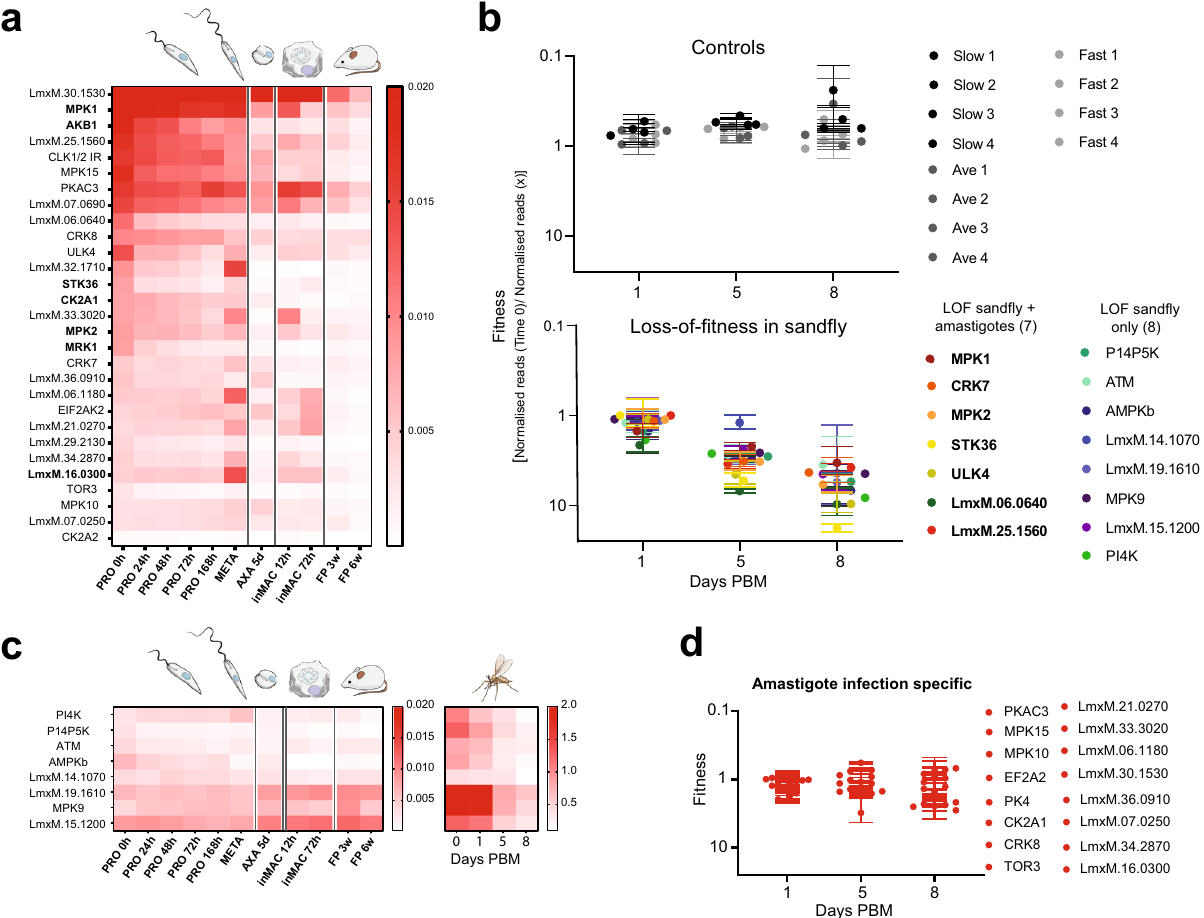
Fig. 5 Identi fi cation of protein kinases involved in colonisation of Lutzomyia longipalpis . a Heat map of 29 protein kinase mutants that cluster in groups important for the amastigote stage in two of the three experiments using 1 difference clustering. In bold are the genes that have been identi fi ed as important for mouse infection in a previous trypanosome study 40 . b Summary showing the protein kinases important for sand fl y infection. Control plot (top) shows the relative barcode representation for four control lines with a barcode inserted in the ribosomal locus at three time points post blood meal (PBM) (days 1, 5 and 8). Protein kinases important for L. longipalpis infection plot (bottom) shows the 15 mutants with signi fi cant loss of representation by day 8 identi fi ed using a multiple t -test, two-stage linear step-up procedure of Benjamin, Krieger and Yekutieli (values are mean ± S.E., n = 2 biologically independent samples). 7 protein kinases identi fi ed as important for both sand fl y infectivity and for survival in amastigote stages indicated in bold. c Heat map showing the amastigote stage data for the 8 protein kinase mutants that are important for sand fl y infection only. Heat maps show the range of normalised reads. d Plot showing the infectivity of the protein kinase mutants important for the survival of amastigotes only, identi fi ed using multiple t -test corrected with post-Holm – Sidak method (values are mean ± S.E., n = 2 biologically independent